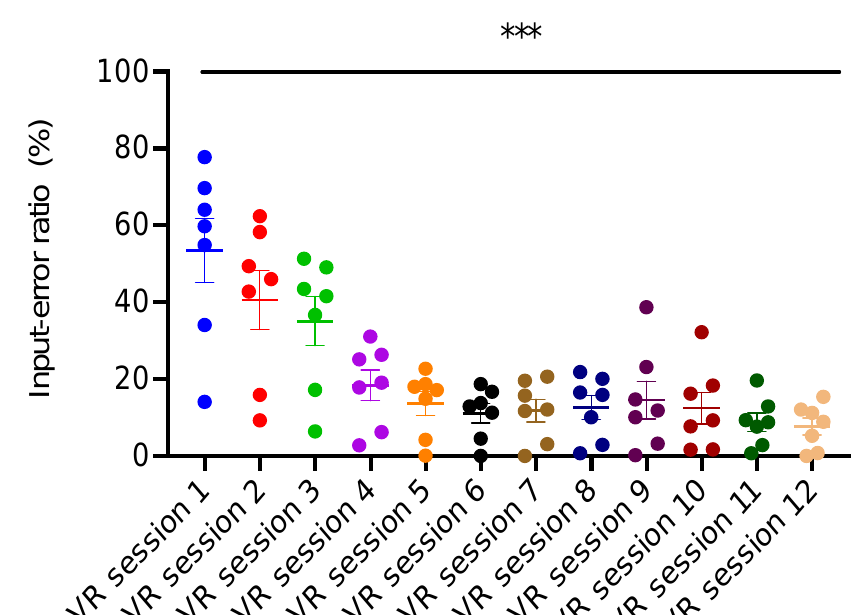
Figure 3. Participants interactivity in the VR assessed via recording of Input-error ratio. Input-error ratio of the participants across the 12 VR sessions significantly decreased in comparison to the first session (One-way repeated measures ANOVA, F = 24.98; *** indicate p < 0.001; n = 7, post hoc comparisons: VR session 1 vs. VR sessions 2,3,4,5,6,7,8,9,10,11,12 p < 0.05). Error bars indicate standard error means.